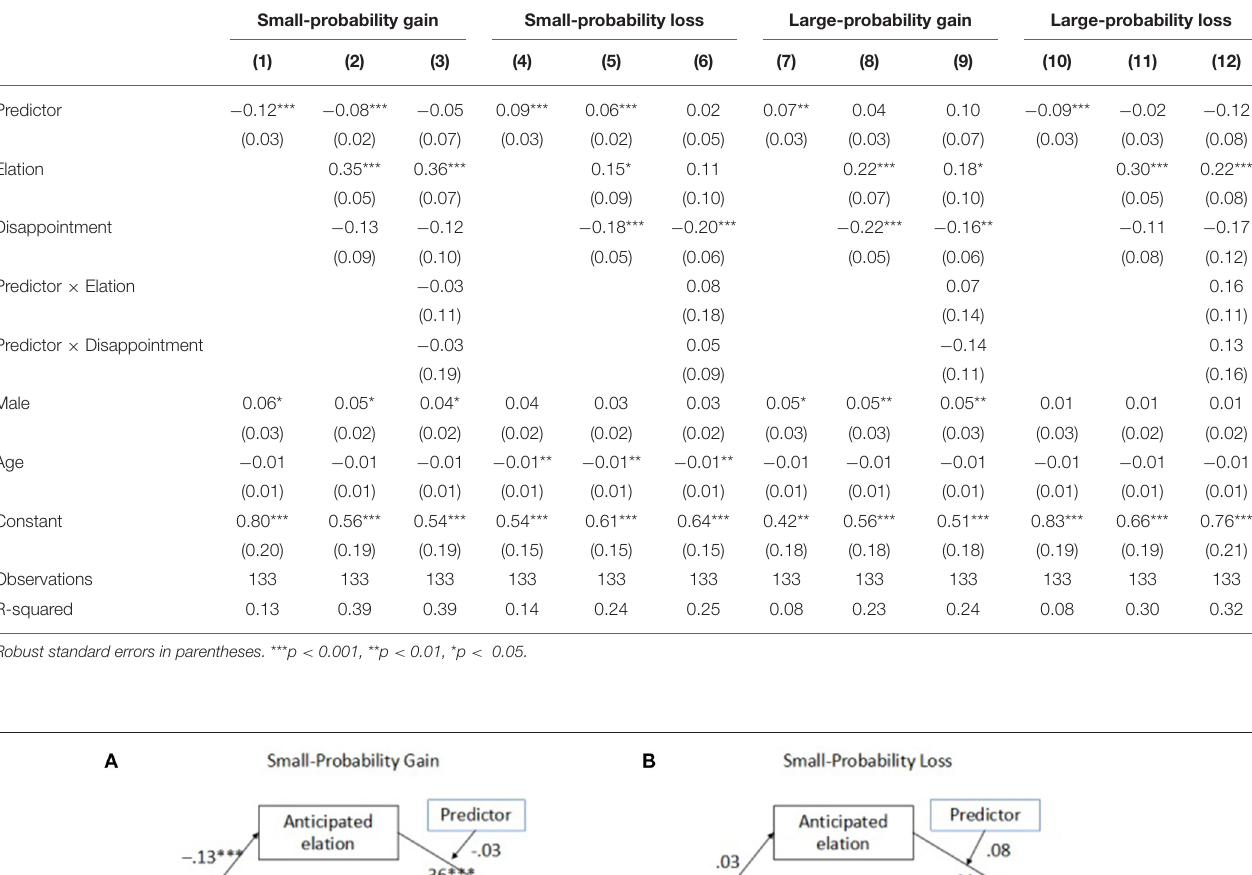
TABLE 2 | Regression analysis on RP index under four different